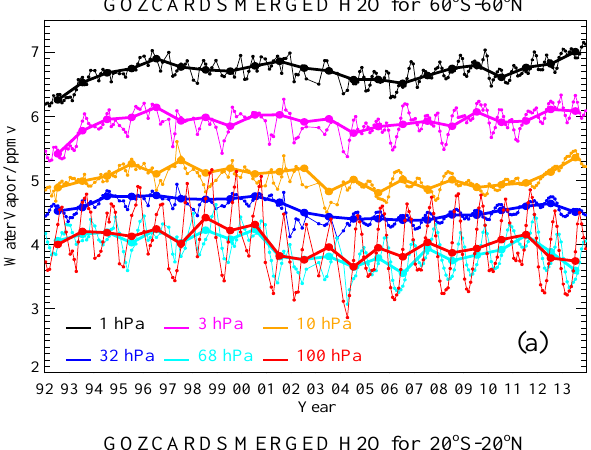
Figure 15. Stratospheric water vapor variability on decadal timescales for 1992 through 2013 for tropical (20 ◦ S–20 ◦ N in black) and midlatitude (20–60 ◦ N in red and 20–60 ◦ S in blue) zonal means, based on the GOZCARDS merged H 2 O data record. The variability is expressed here as the difference between maximum and minimum annual average abundances, from 100 to 1hPa, in ppmv (left panel) and percent (right